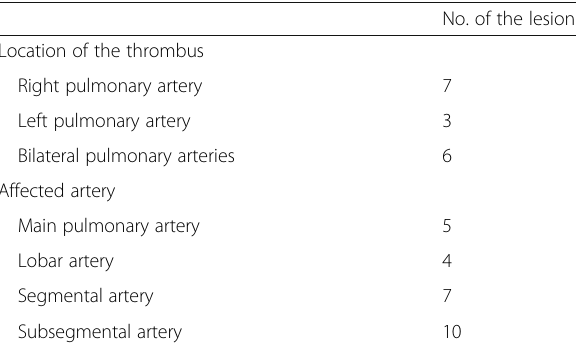
Table 2 The findings of multi-detector CTPA in patients who were positive for PE